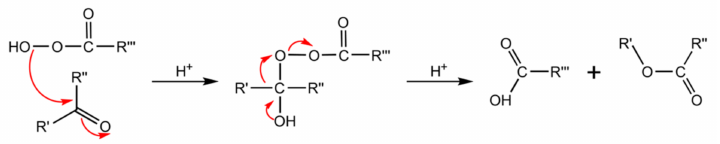
Figure 2. Mechanism of Baeyer-Villiger oxidation. A common chromogen in extrinsic tooth discolouration is polyphenols. These organic molecules are found abundantly in various coloured foods and beverages (including tea and red wine). They can be oxidised by peroxyacids to quinones and then potentially undergo further rearrangement